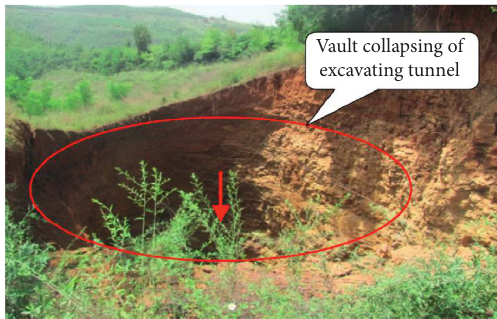
Figure 4: Vault collapsing of excavating